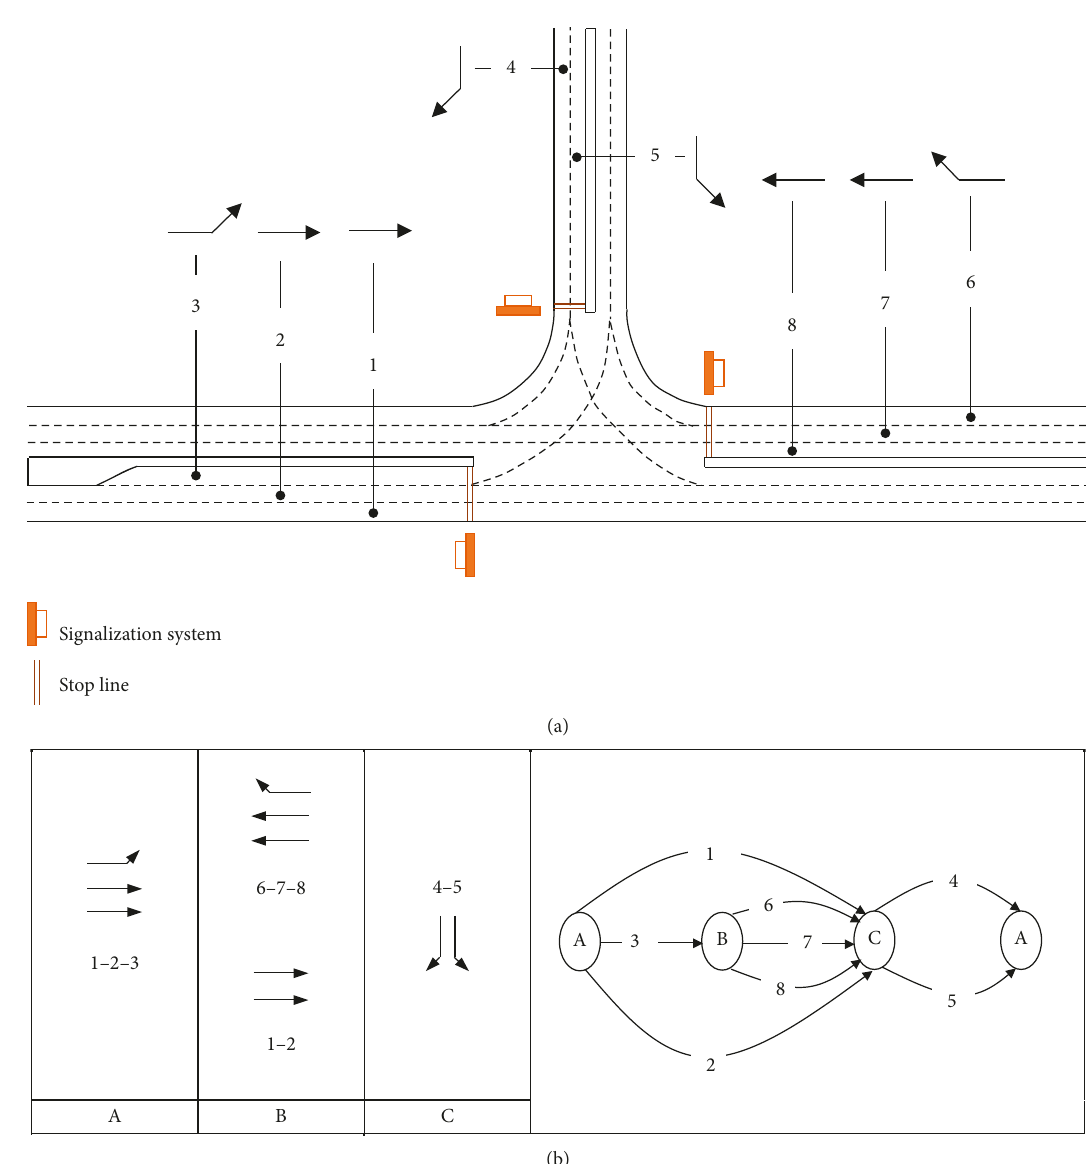
Figure 1: (a) The intersection model. (b) Sample phase plan with movement-based cycle